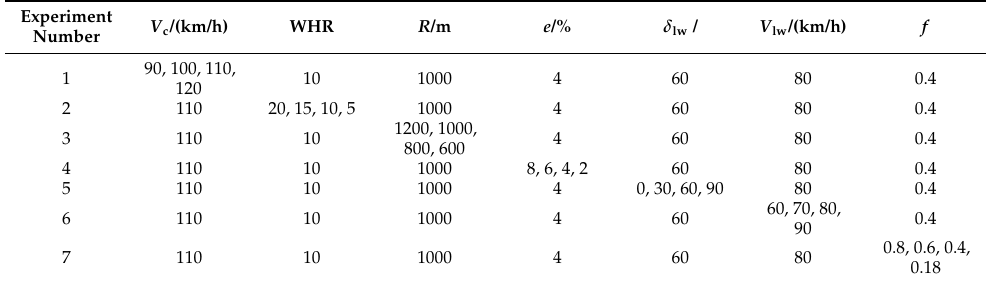
Table 1. Simulation schemes design of single-factor